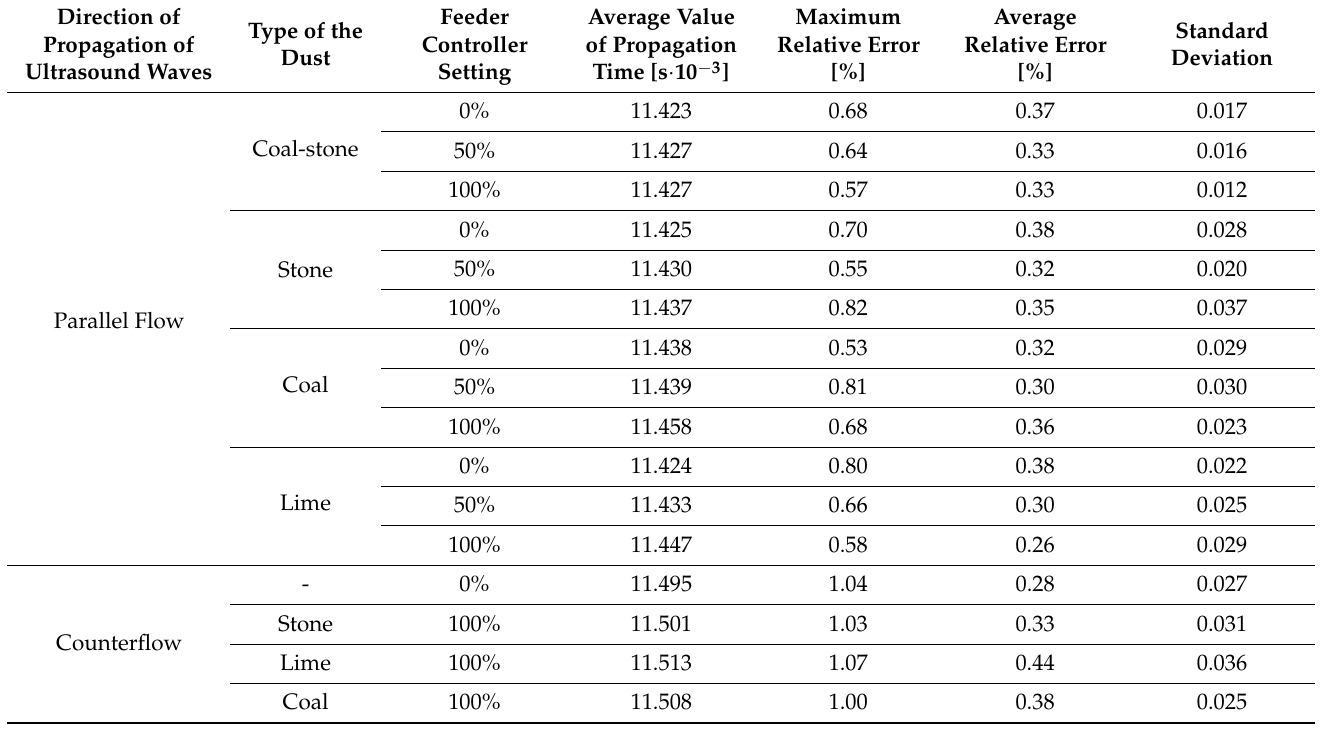
Table 3. Values of errors and uncertainties in measuring the propagation time of ultrasonic waves — AR30.